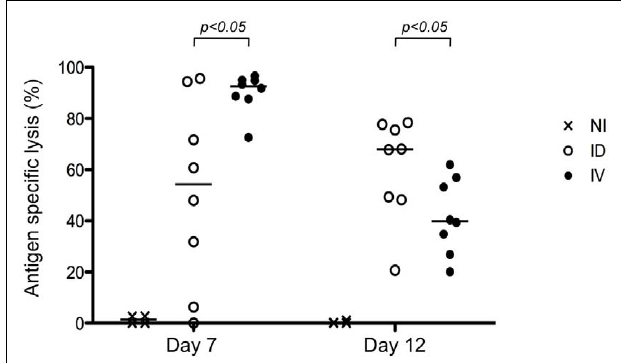
FIGURE 2 | Both i.v. and i.d. immunization result in CTL induction. Mice were immunized i.d. or i.v. with 5 × 10 5 K bm1 mOva splenocytes. At day 7 or 12 post-immunization, an in vivo cytotoxicity assay was performed. Antigen-specific killing is reported. p -Values were calculated using a Mann–Whitney test (comparing ID versus IV). NI, non-immunized mice, shown here to indicate baseline killing